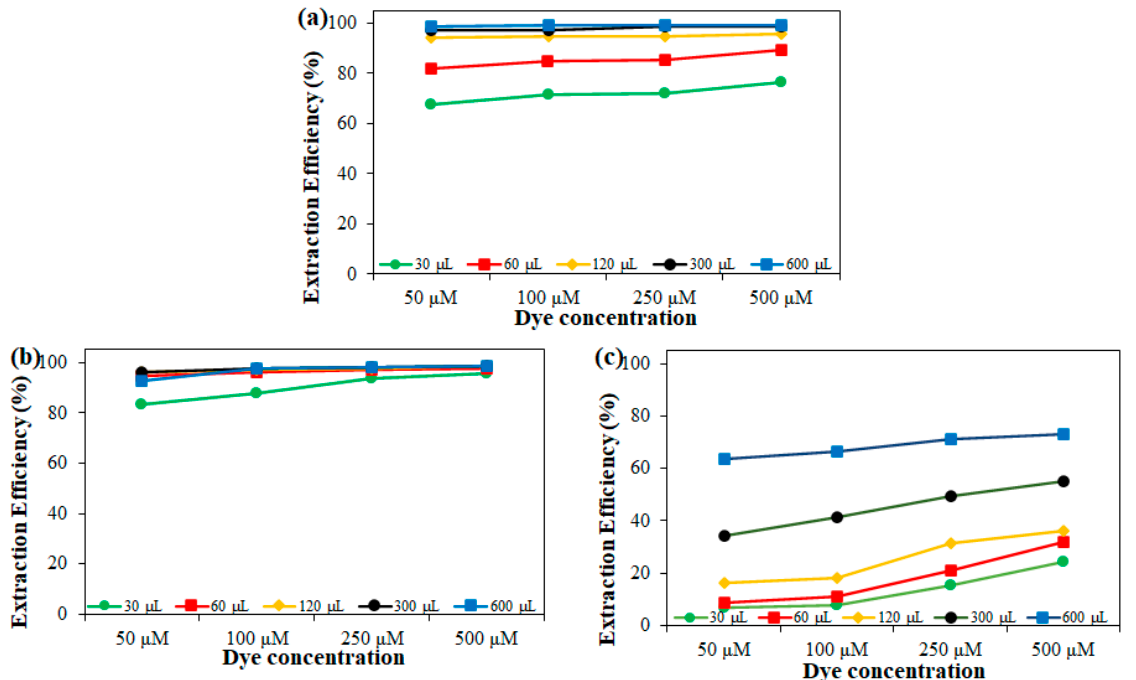
Figure 4. Dye extraction efficiencies after 24 h exposure of the dye solution with the C12:C6 mixture: ( a ) malachite green, ( b ) methyl violet, and ( c ) methylene blue at various dye concentrations (50 µ mol/L, 100 µ mol/L, 250 µ mol/L, and 500 µ mol/L) and extractant volume: 30 µ L (green circle), 60 µ L (red square), 120 µ L (yellow diamond), 300 µ L (black circle), and 600 µ L (blue square). The error bars are the standard deviations from the three trials. Table 1. Highest and lowest extraction efficiencies of the methylene blue (MB), methyl violet (MV), and malachite green (MG) dye solutions with the C12:C6 mixture at 24 h contact time.